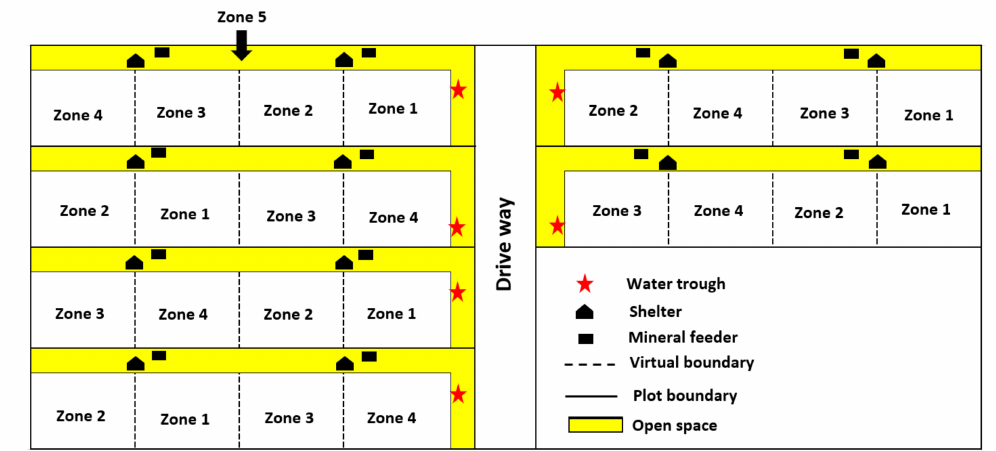
Figure 1. Schematic diagram of research plots showing different zones and locations for shelters min- eral feeders and water troughs, June–August 2018, Atkins Agroforestry Research and Demonstration Site, Tuskegee University, Tuskegee, Alabama, USA. Zone 1: Non-pine plants left uncut (control); Zone 2: Non-pine plants cut to the ground level; Zone 3: Non-pine plants cut to 0.9 m from the ground level; Zone 4: Non-pine plants cut to 1.5 m from the ground level; Zone 5: Fence line and driveway where shelters, mineral feeders, and water troughs were located.